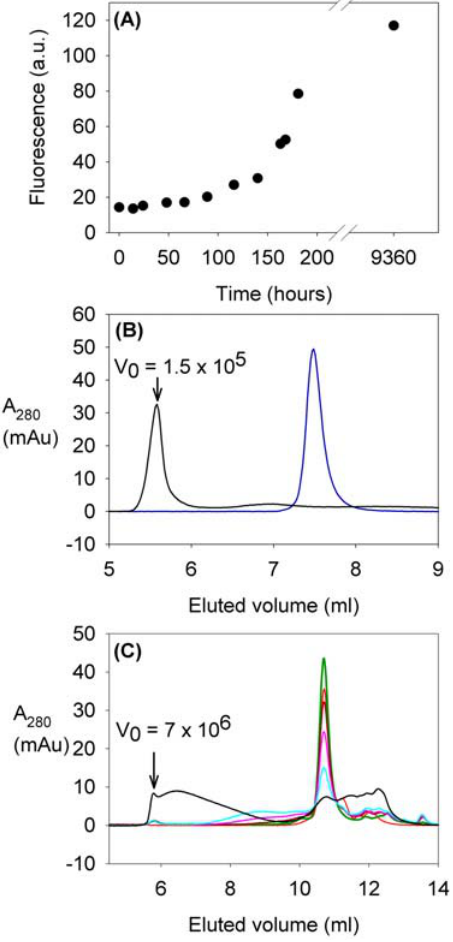
Figure 4. Formation of oligomeric structures when apo T54R SOD1 mutant is incubated at 37 u C. (A) Fluorescence due to ThT binding to SOD1 mutants (presented as arbitrary units, A.U.) for apo T54R SOD1 during the incubation of the samples at 37 u C. Panels (B) and ( C ) shows the size exclusion chromatograms on a G2000SW XL and a G4000SW XL Tosoh columns respectively, corresponding to the samples analyzed by light scattering. The void volume is labeled V 0 . In all four panels the samples can be identified according to the following colors: before incubation ( — ), after 66 hours ( — ), 4.8 days ( — ), 6.8 days ( — ),7.5 days ( — ), and 13 months ( — ) of incubation at 37 u C. In panel (B) the zinc reconstituted sample ( — ) is also reported.